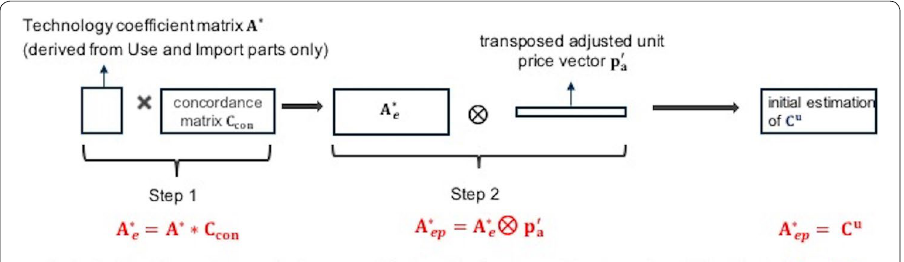
Fig. 4 Initial estimation of C